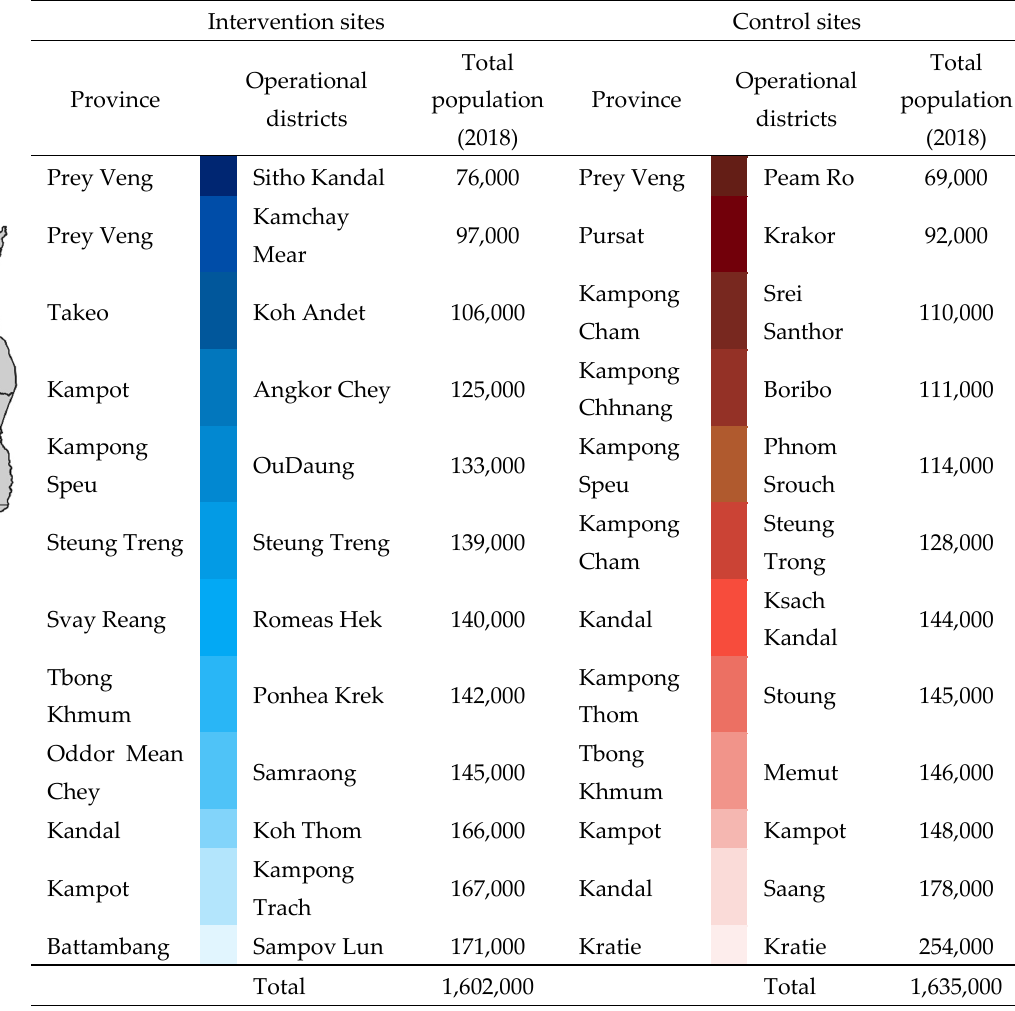
Figure 1. Location of study sites. Districts highlighted in shades of blue and red were intervention and control sites, respectively. Spatial data were extracted from Open Development Cambodia (2014). Light grey lines represent district borders, and black lines represent province borders. Total population data (2018) were rounded up to the nearest